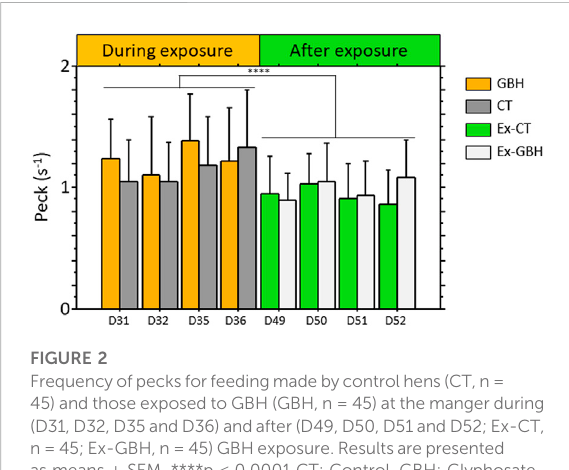
FIGURE 2 Frequencyofpecksforfeedingmadebycontrolhens(CT,n= 45) and those exposed to GBH (GBH, n = 45) at the manger during (D31,D32,D35andD36)andafter(D49,D50,D51andD52;Ex-CT, n=45;Ex-GBH,n=45)GBHexposure.Resultsarepresented as means ± SEM. ****p ≤ 0.0001 CT: Control, GBH: Glyphosate- Based Herbicide, Ex-CT: Ex-Control, Ex-GBH.